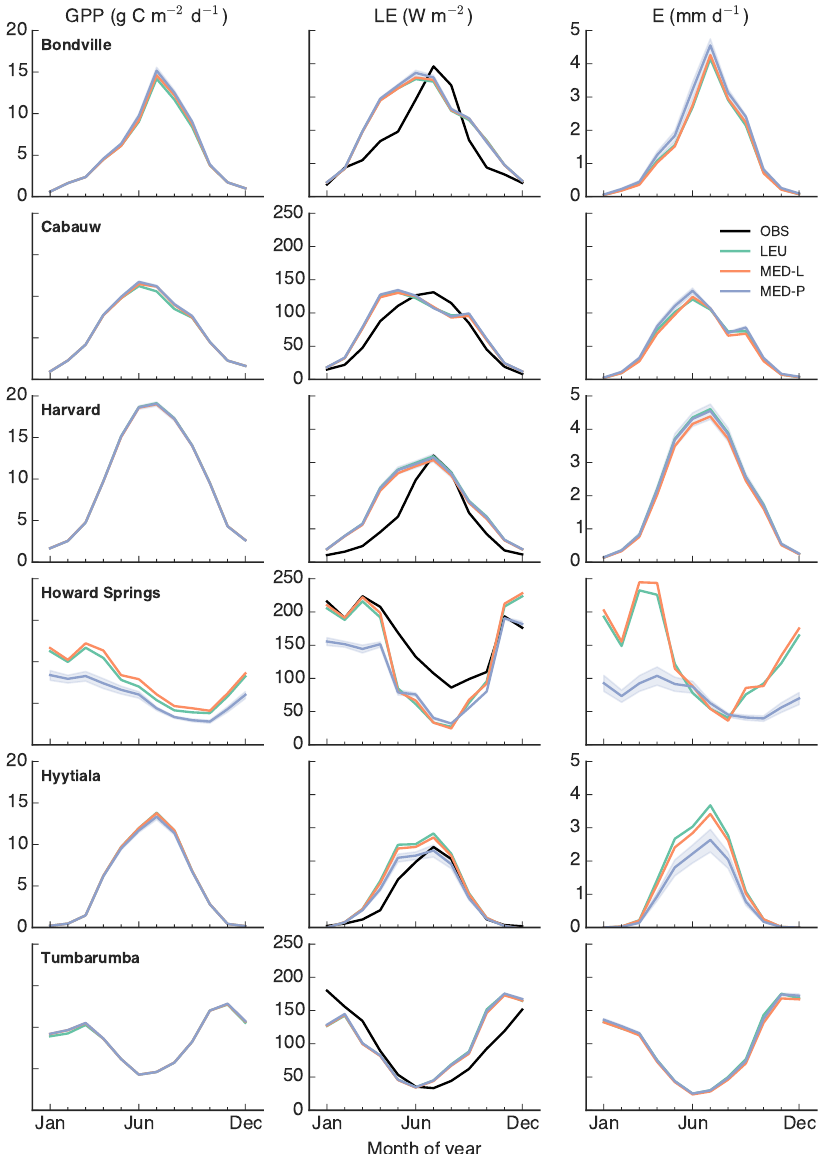
Figure 3. A comparison of the modelled average seasonal cycle of gross primary productivity (GPP), latent heat flux (LE), transpiration ( E ) and the observed (OBS) LE flux at six FLUXNET sites during approx. daylight hours (8a.m.–7p.m.). Time series have been averaged across all years as described in Table 4 to produce seasonal cycles. Light blue shading indicates the uncertainty in predicted fluxes from the Medlyn model (MED-P), accounting for ± 2 standard errors in the site g 1 parameter